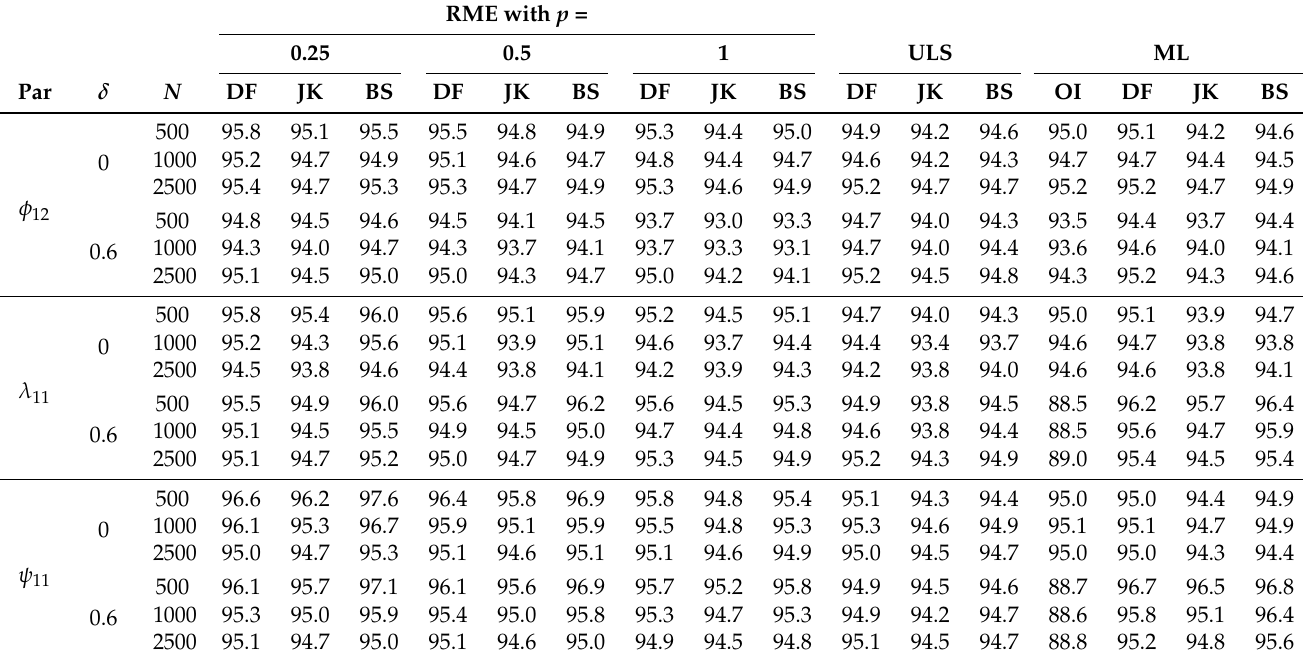
Table 2. Focused Simulation Study 1A: Coverage rate at confidence level 95% of model parameter estimates as a function of sample size N and size of residual error correlations δ for different standard error estimation